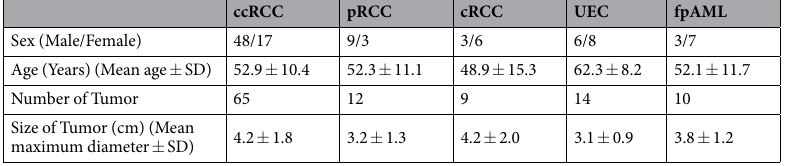
Table 1. Patient information and pathologic results (n = 110). Note: ccRCC, pRCC, cRCC, UEC, fpAML represent clear cell renal cell carcinoma, papillary renal cell carcinoma, chromophobic renal cell carcinoma, uroepithelial carcinoma, and fat poor angiomyolipoma,